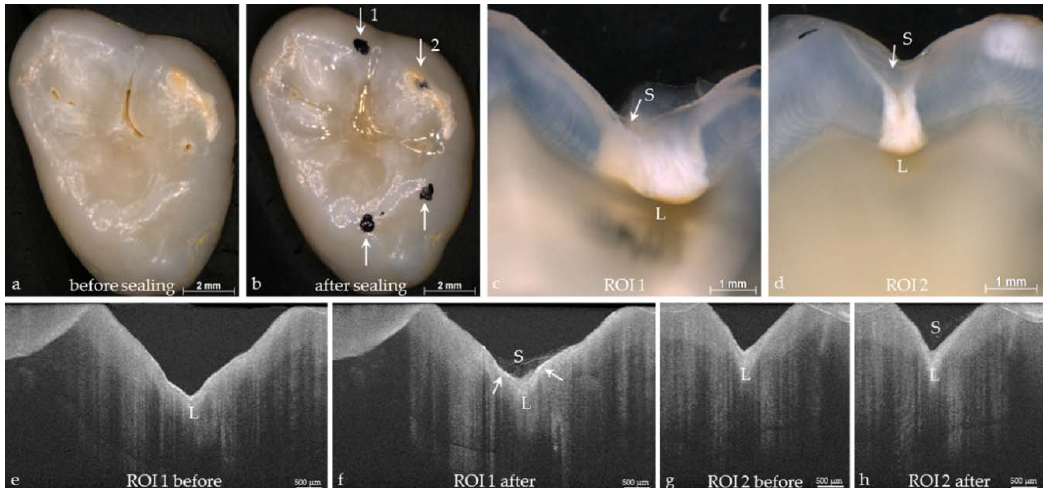
Figure 14. ( a ) Extracted human molar before; and ( b ) after fissure sealing with Helioseal. ( c , d ) In cross-sections through ROI 1 and 2 occlusal caries beneath the sealer can be identified (L). Using SD-OCT, carious lesions (L, shadow) can be localized ( e , g ) before; and ( f , h ) after sealing. The sealer (S) has penetrated into the fissures, is inhomogeneously distributed and adapted to the enamel surface with ( f , white arrows) or ( h ) without interfacial gap; ( f ) The bright signals reveal an interfacial gap (white arrows) between sealant and enamel. Monitoring will reveal changes over time.